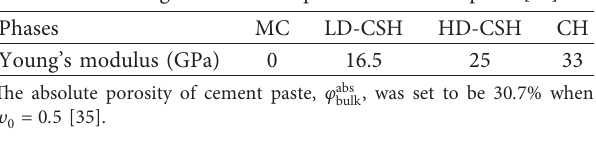
Table 2: Young’s modulus of phases in cement paste [15].